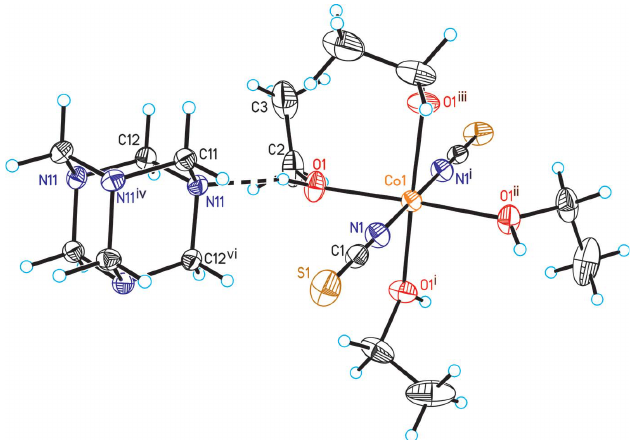
(cid:4) y , (cid:4) 1 (cid:4) x , (cid:4) 1 (cid:4) z ; , 1 + x , z (cid:4) 1 ; (iii) (cid:4) 1 2 2 2 2 2 2